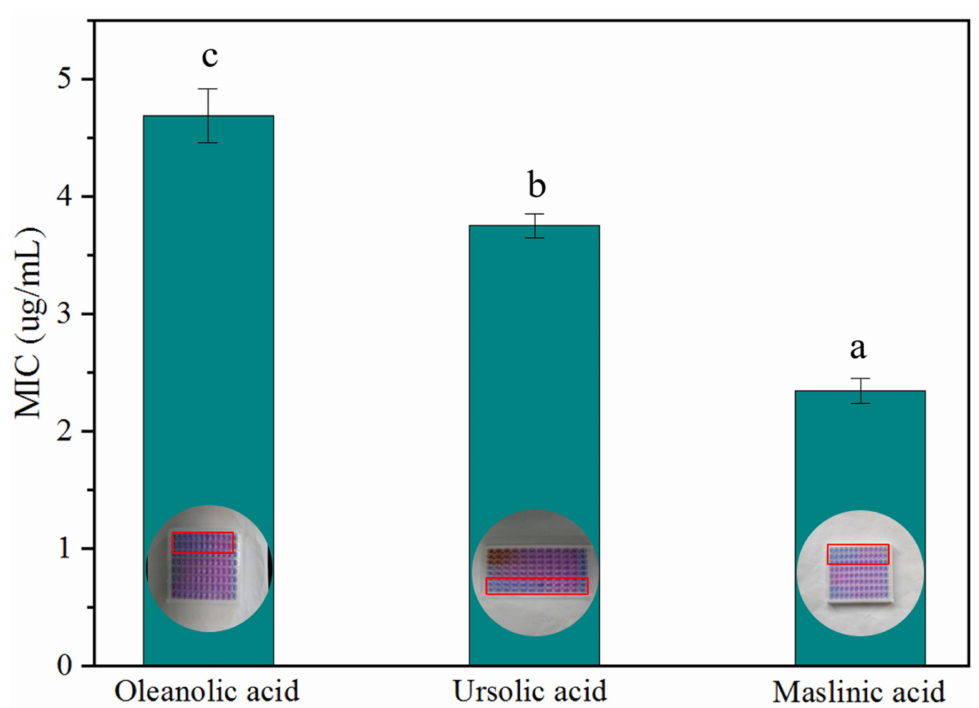
Figure 7. MIC of OA, UA, and MA against S. aureus . Values with different letters as the label are significantly different between compounds ( p <